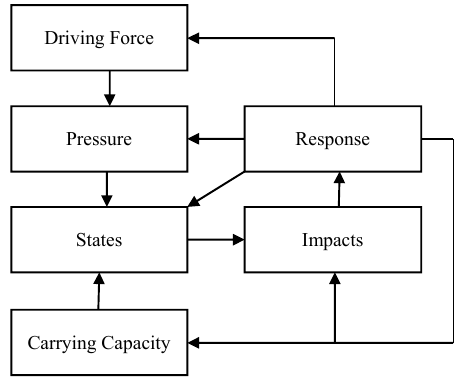
Figure 2. Driving Forces-Pressures-State-Carrying Capacity-Impacts–Responses (DPCSIR) model.